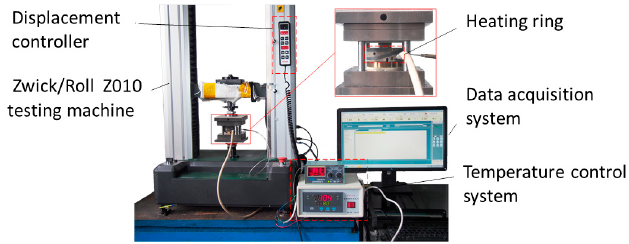
Figure 1. Testing system of micro-embossing.